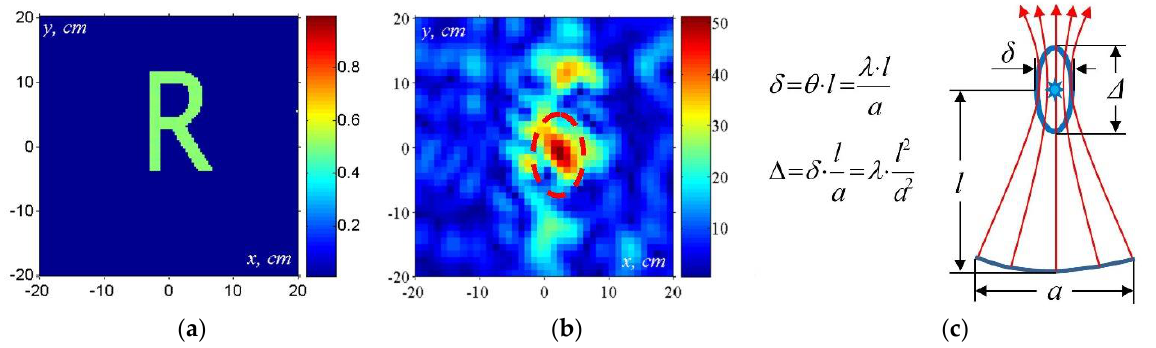
Figure 10. Test object ( a ) and its diffraction-limited image ( b )—experiment; estimates ( c ) of longitudinal ∆ and transversal δ resolution for a finite antenna aperture a . Red arrows symbolize complex rays of backward wave migration, blue ellips marks the focal spot size.